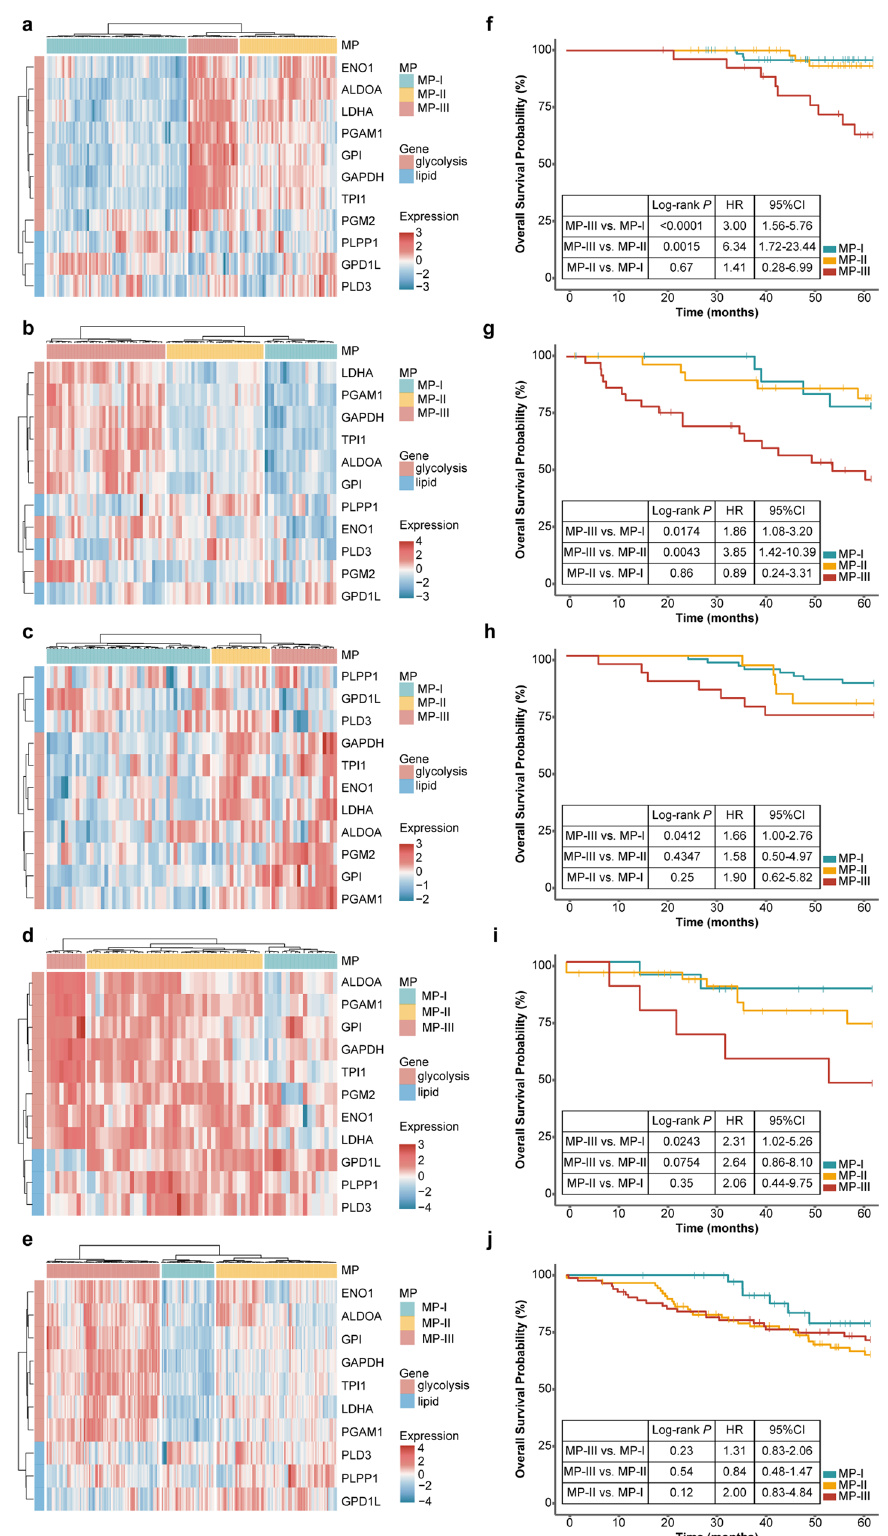
Fig. 3 Recon fi rmation of the MPs and survival in multiple cohorts. a – e Hierarchical clustering heatmap for treatment-naive patients with stage I LUAD based on the mRNA expression (Z-score) of the 11 metabolic genes in the GSE31210 ( n = 162 biologically independent samples), GSE50081 ( n = 92 biologically independent samples), GSE13213 ( n = 79 biologically independent samples), GSE42127 ( n = 67 biologically independent samples), and GSE68465 ( n = 223 biologically independent samples) datasets. f , j Kaplan – Meier curves of overall survival for the fi ve